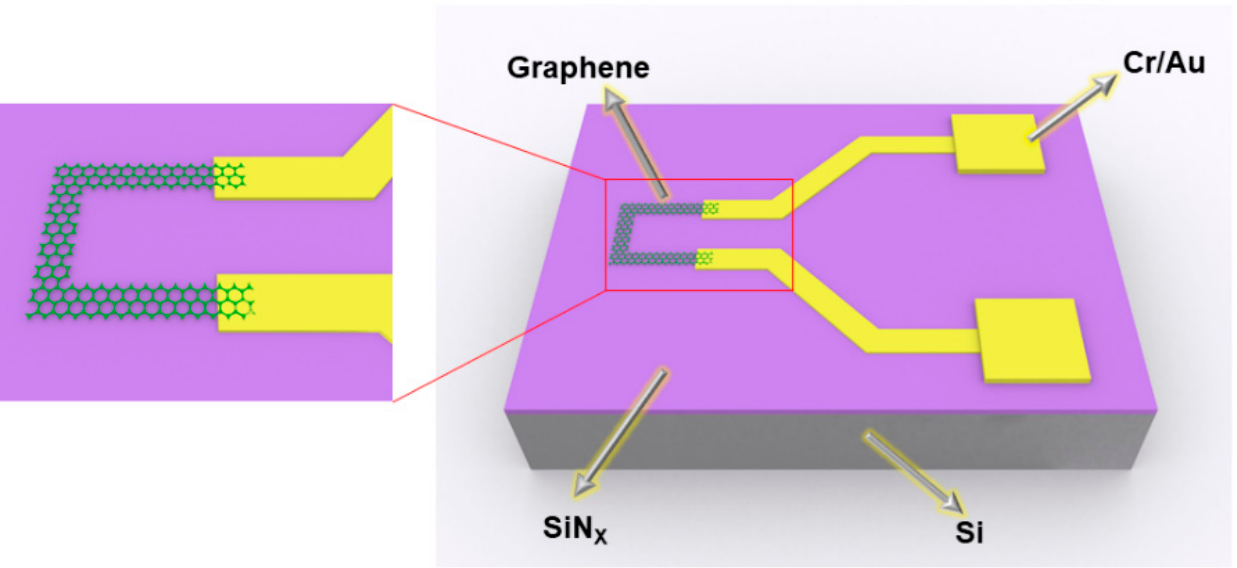
Figure 2. The structure diagram of the graphene temperature sensor.